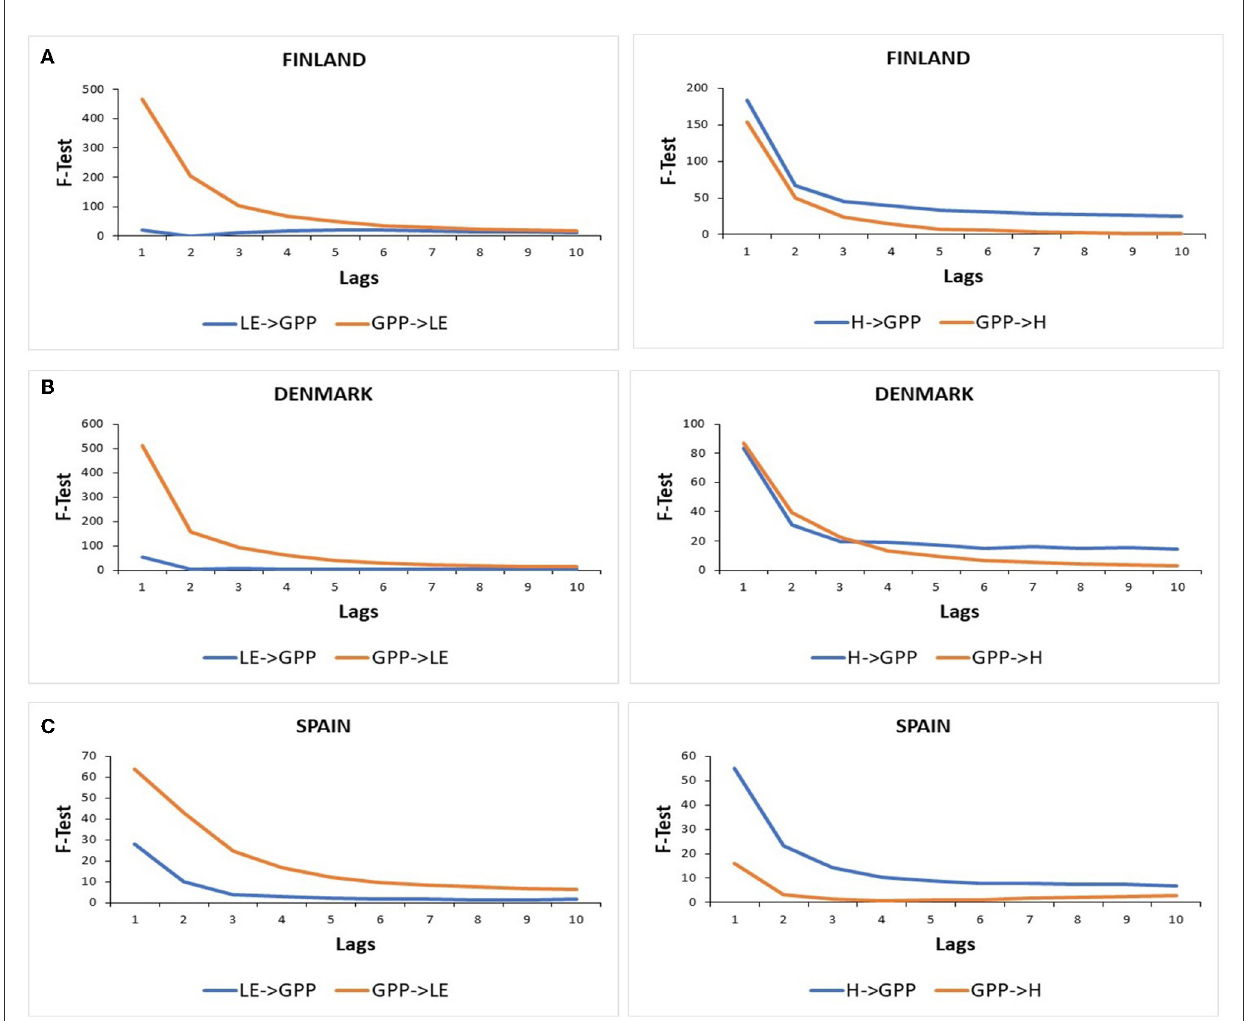
FIGURE7 Granger causality tests between GPP, LE, and H in both directions (i.e., energy flux variable cause GPP and GPP cause energy flux variable) for (A) the Evergreen Needleleaf Forest of Finland (ENF_FI), (B) the Deciduous Broadleaf Forest of Denmark (DBF_DK), and (C) the Mediterranean forest of Spain (SAV_SP). Critical values for F-statistic at 0.05 significance level: lag 1 = 3.84, lag 2 = 3.00, lag 3 = 2.60, lag 4 = 2.37, lag 5 = 2.21, lag 6 = 2.10, lag7 = 2.01, lag 8 = 1.94, lag 9 = 1.88, and lag10 =